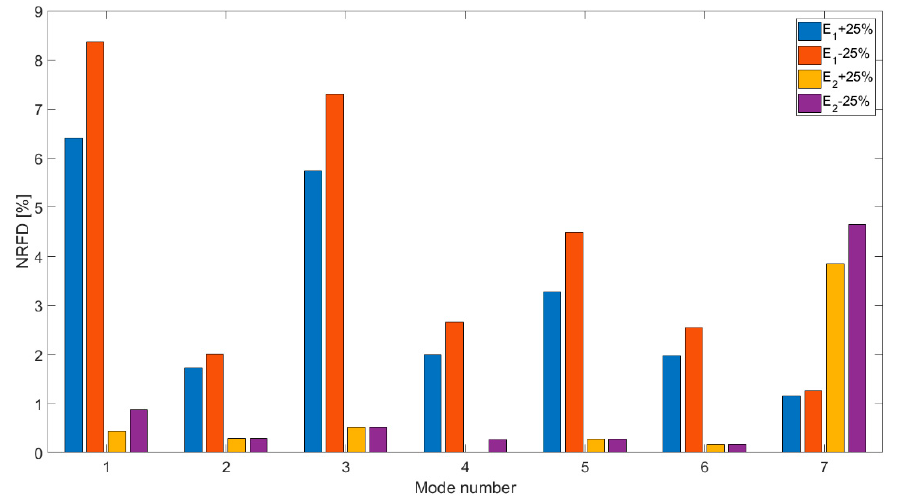
Figure 7. NRFDs of Young’s moduli.